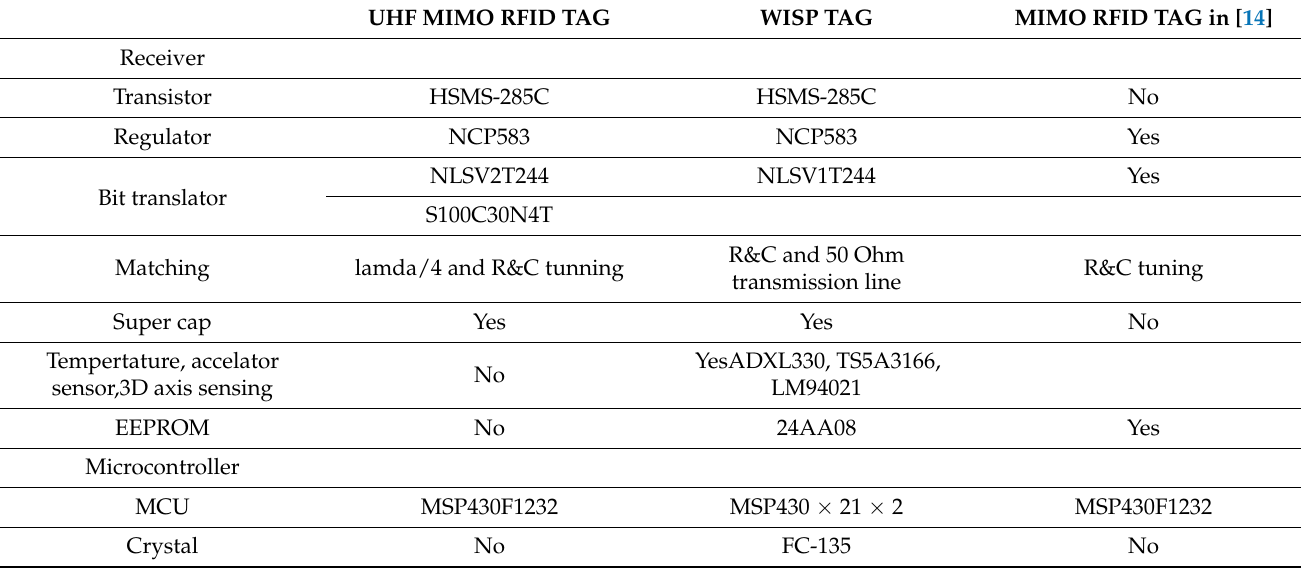
Table 1. WISP and UHF MIMO RFID TAG RF design